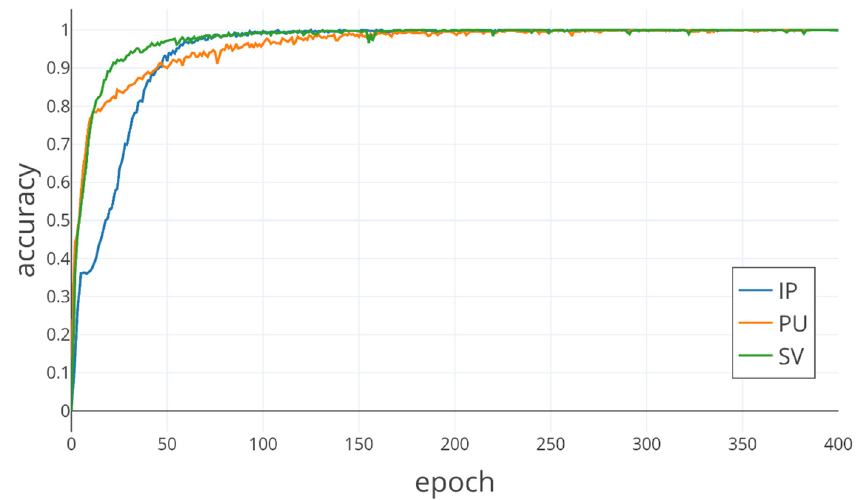
Figure 10. In three datasets, classification accuracy for each epoch during training. Table 6. Parameters for the proposed Bi-LSTM-CNN method on the IP